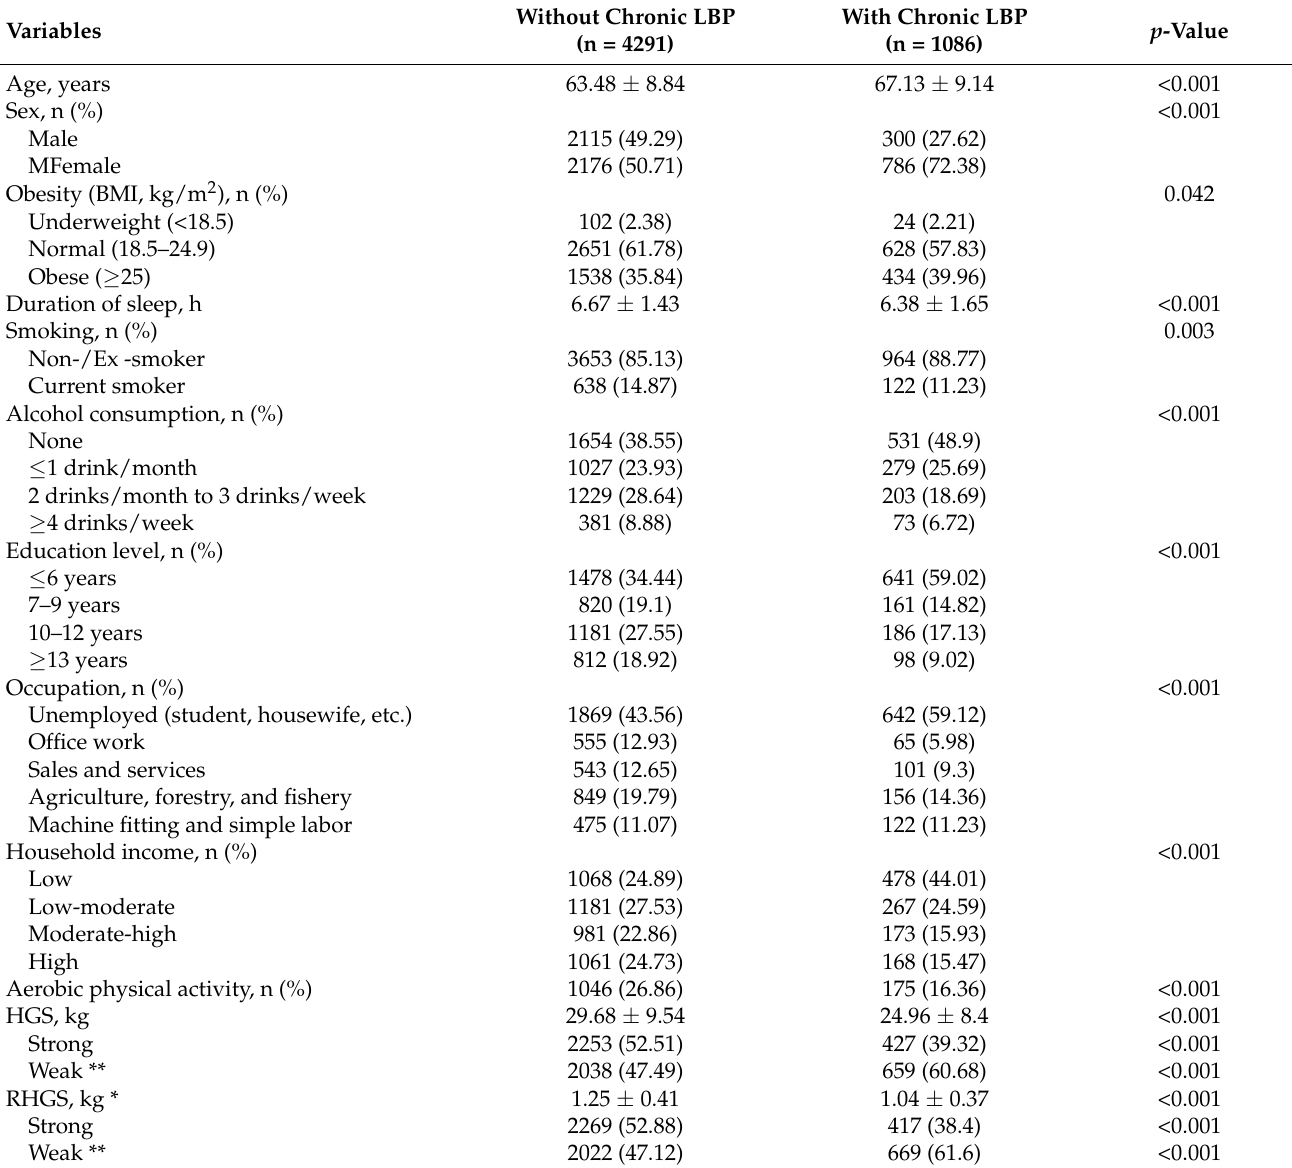
Table 1. General participant characteristics according to knee